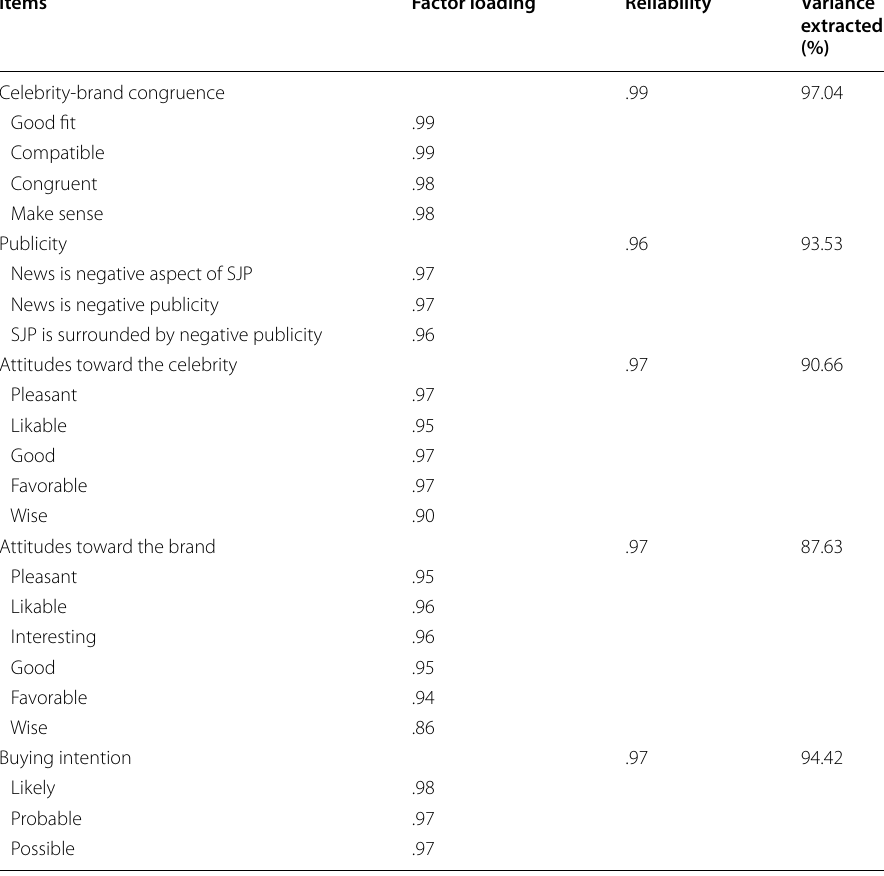
Table 2 Results of exploratory factor